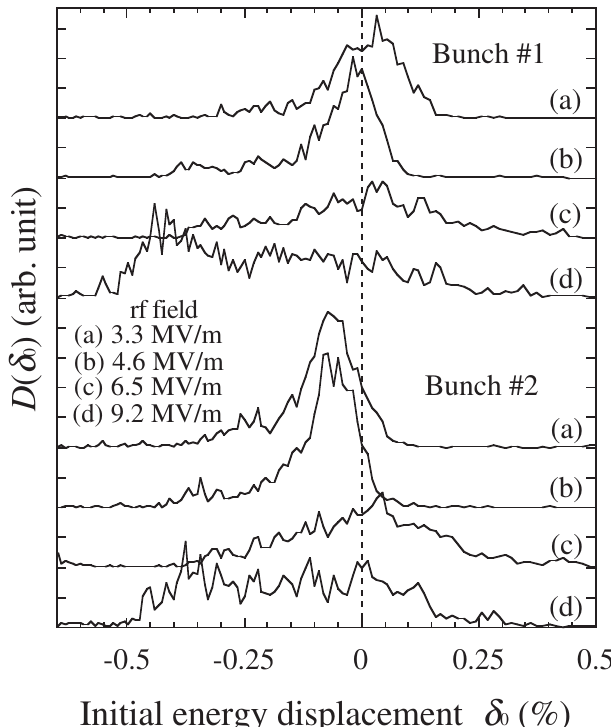
FIG. 8. Energy profiles of the front bunch (#1) and rear bunch (#2) for various rf fields, using an ECS.